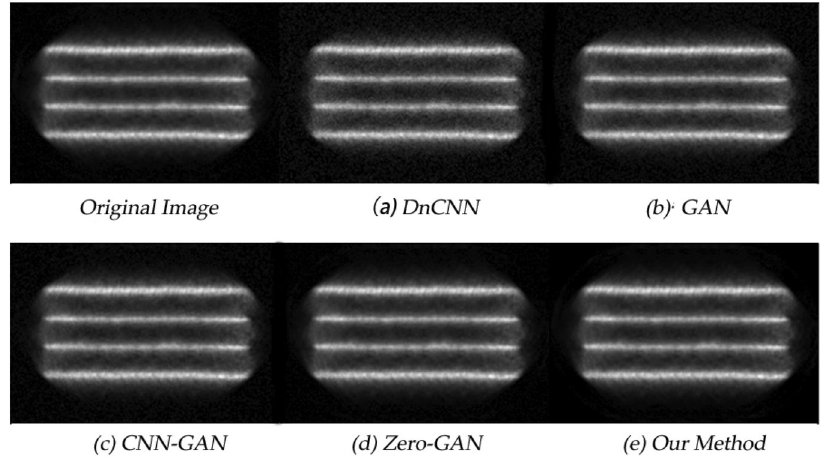
Figure 6. The positron flow field images are the laminar flow images obtained by simulation. The specific parameters are sampling time 1s and nuclide activity 800 bq.